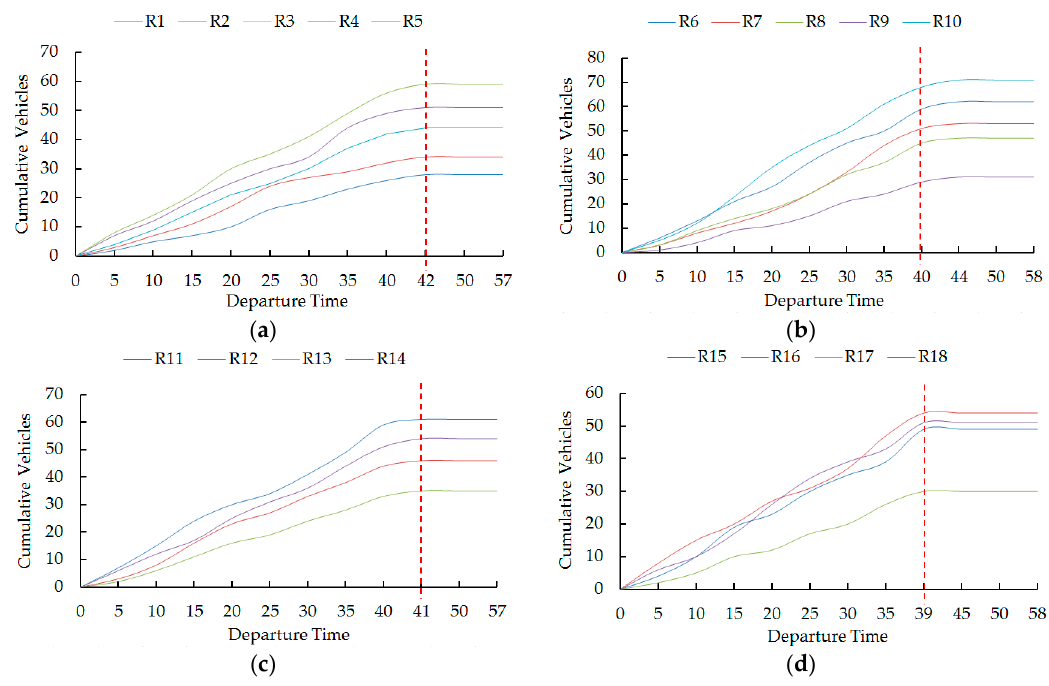
Figure 6. Dynamic evacuation process from the four exits of the parking lot. ( a ) Exit E1. ( b ) Exit E2. ( c ) Exit E3. ( d ) Exit E4.